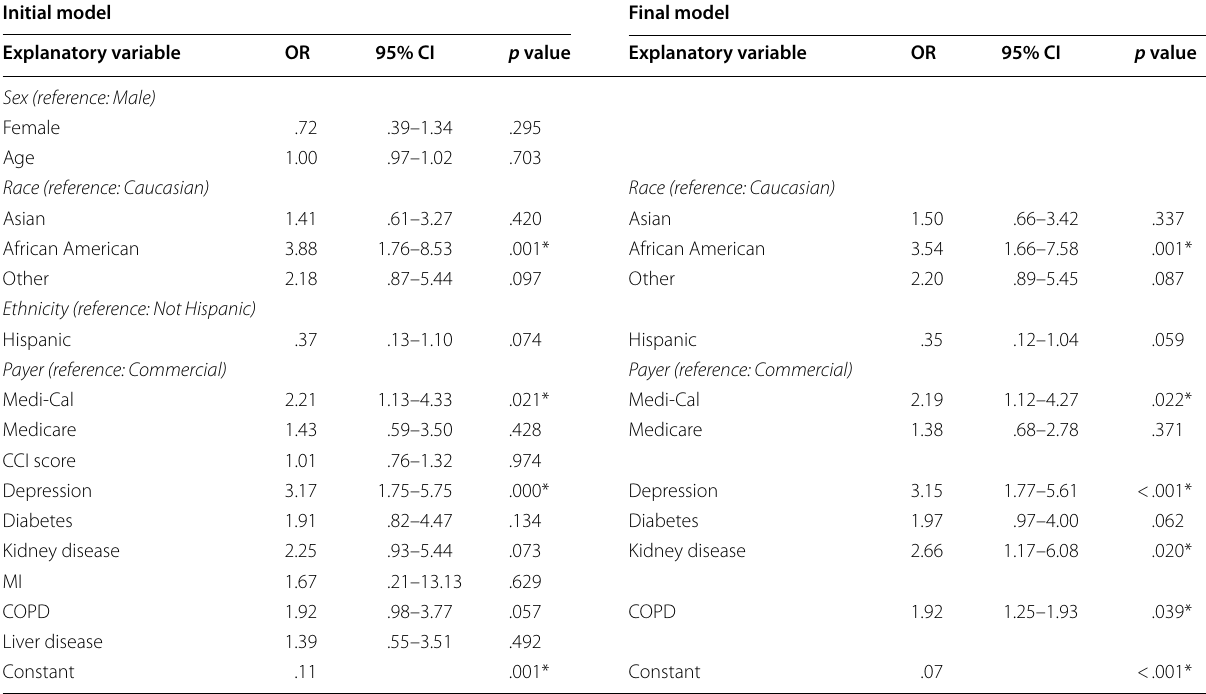
Table 4 Associations of patient characteristics with meeting MH-LOW